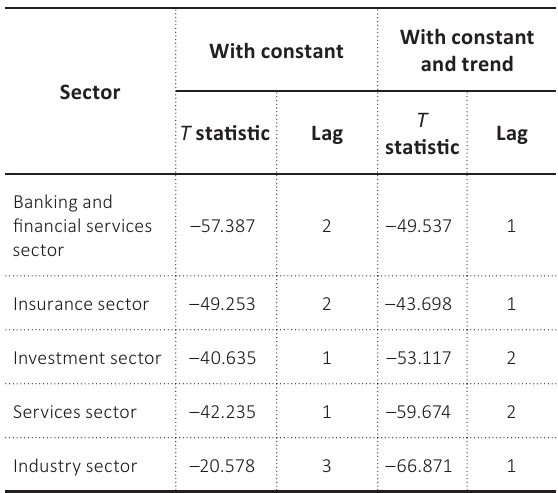
Table 7. Augmented Dickey-Fuller unit root tests for return